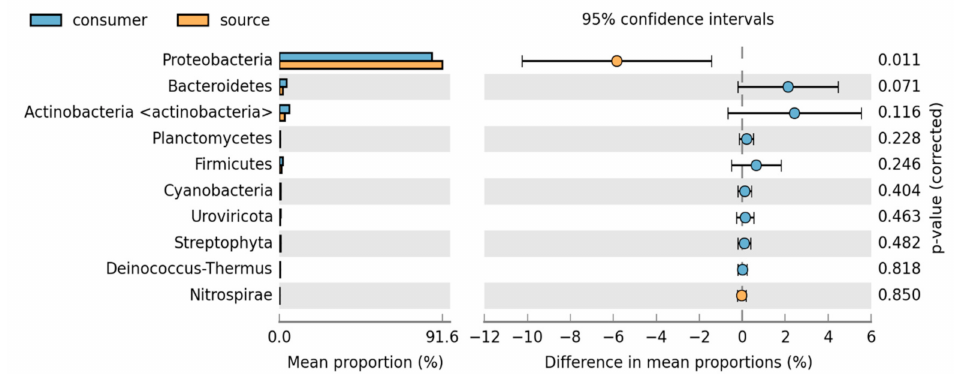
Figure 3. Differential abundance profile (phylum level) between source and consumer-end biofilm samples on the basis of Fischer’s exact t -test with Storey’s FDR correction at 95% confidence